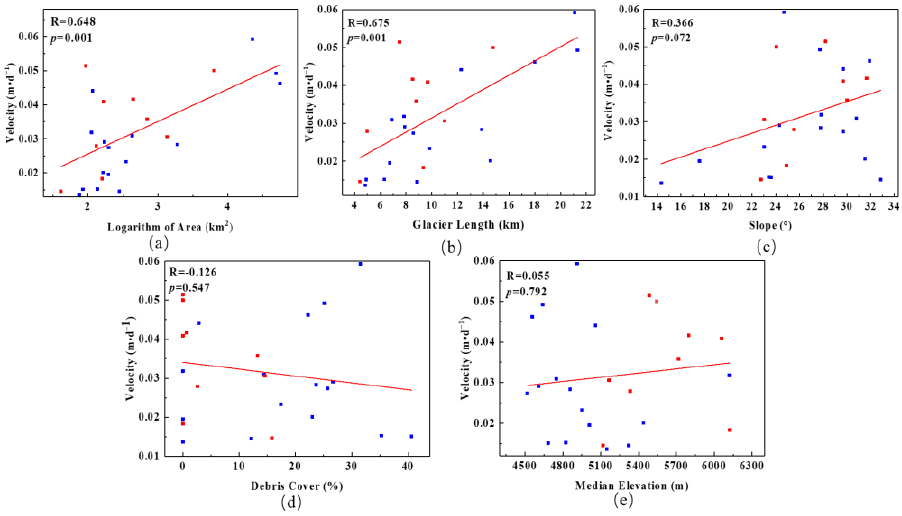
Figure 10. The results of linear regression analysis between glacier velocity and local morphological factors in the Muztag-Kongur Mountains: ( a ) logarithm of area; ( b ) length; ( c ) slope; ( d ) debris cover; ( e ) median elevation. The blue dots indicate glaciers on northern slopes, and the red dots indicate glaciers on southern slopes. R is the linear correlation coefficient between glacier velocity and local morphological factors, and p is the strength of the correlation.